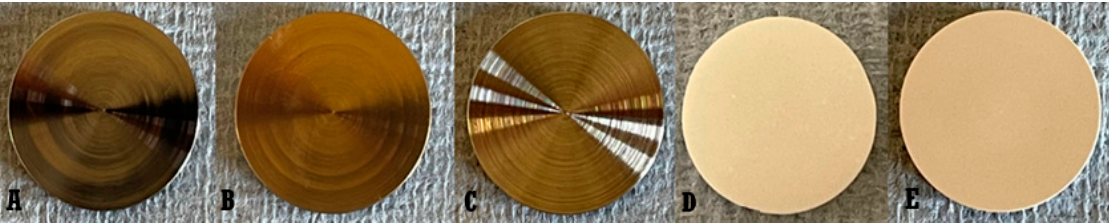
Figure 1. Abutment materials discs ( A : Ti, B : TiN, C : CoCr, D : ZrO 2 , E : m-PEEK). All discs were prepared, cleaned, sterilized, and packaged by Zimmer Biomet 3i (Palm Beach Gardens, FL,